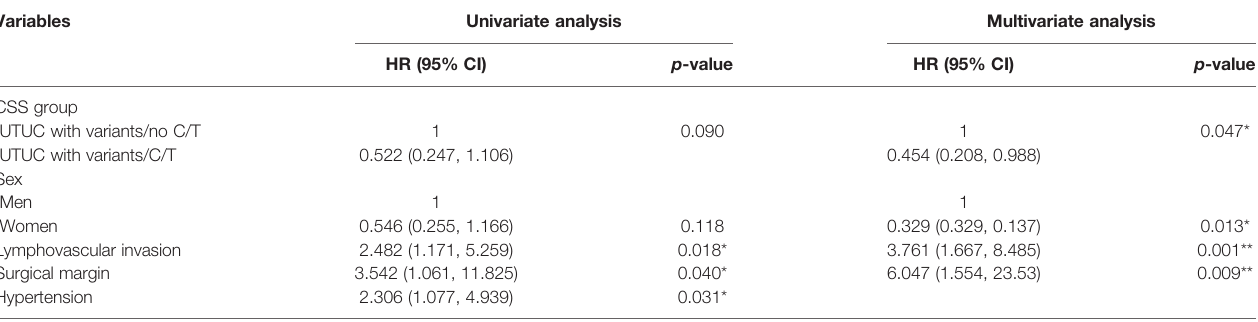
TABLE 4 | Univariate and multivariate regression cancer-speci fi c survival (CSS) analyses in patients with variant upper tract urothelial cancer (UTUC) undergoing radical nephroureterctomy (RNU).